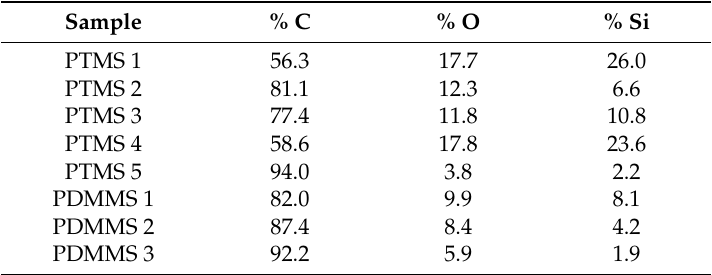
Table 2. Elemental composition for each propyltrimethoxysilane (PTMS) and propyldimethylmethoxysilane (PDMMS) sample found by XPS.